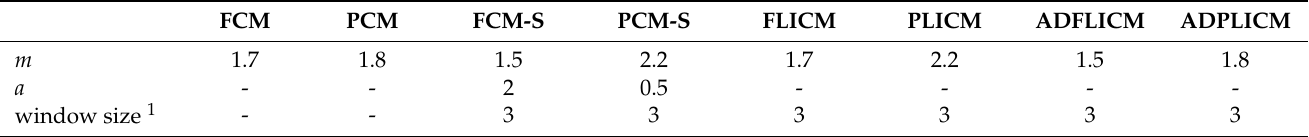
Table 1. The parameter values optimized for the conventional classifiers and the local spatial information classifiers for supervised classification with all the